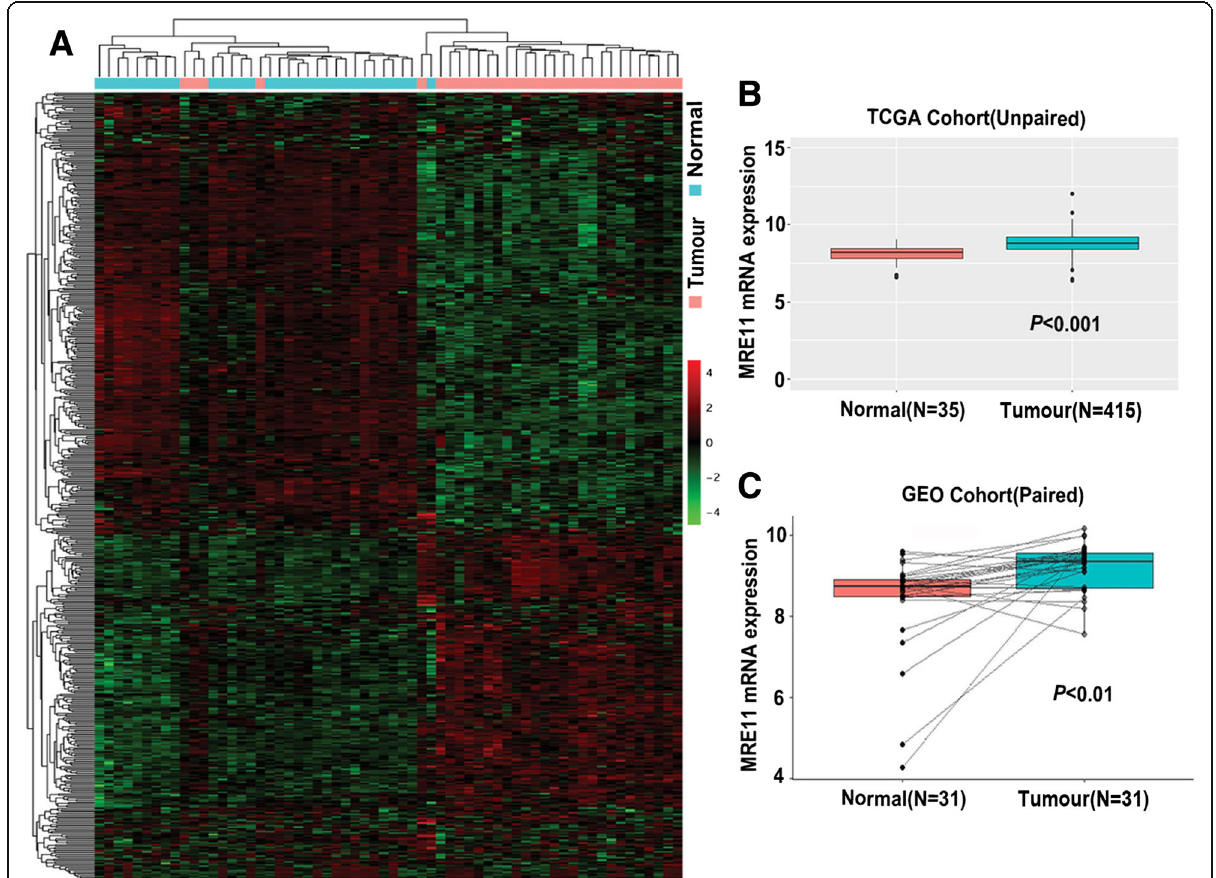
Fig. 1 High MRE11 expression in GC. a Analysis of TCGA data in a heat map. b MRE11 mRNA expression in unpaired GC and normal tissues from the TCGA database. c MRE11 mRNA expression in paired GC and normal tissues from the GEO